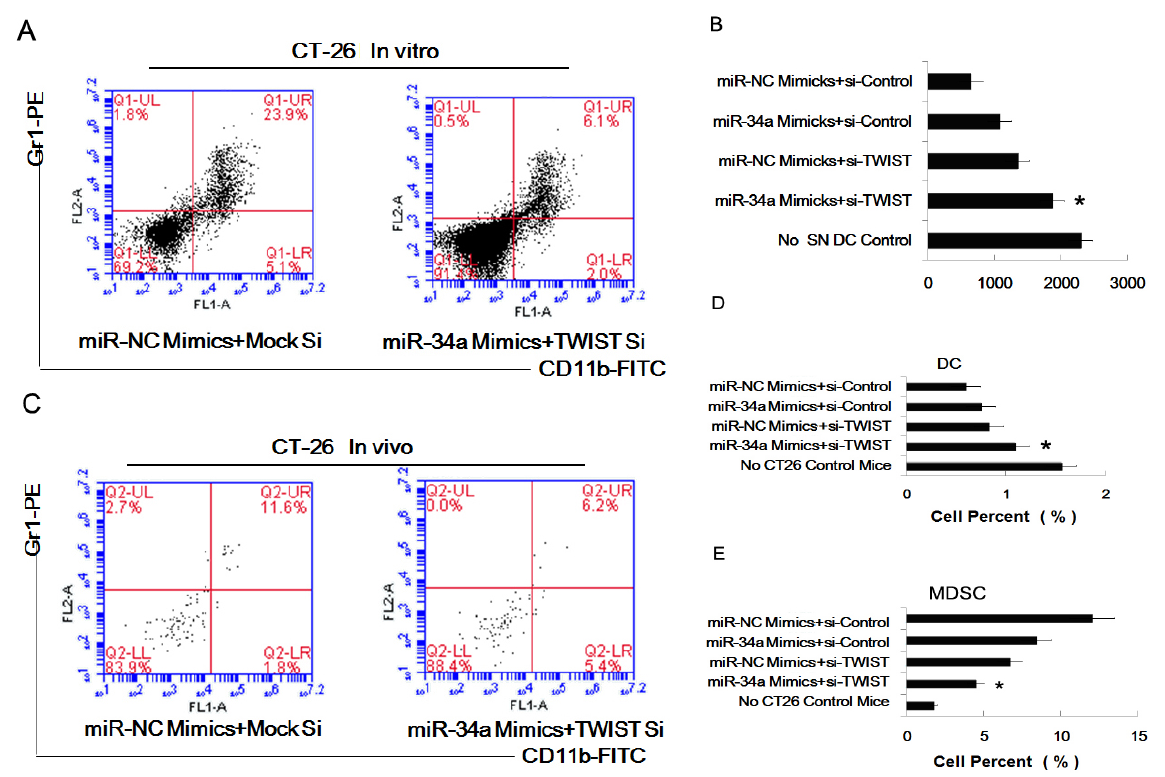
Figure 5. The combined effect of Twist and miR-34a in inducing MDSC. miRNA-34a mimics and Twist siRNA were combined to pretreated tumor cells. The supernatants of pretreated cells were collected and co-cultured with myeloid precursor cells; or the combined treated tumor cells were inoculated s.c. into C57BL/6 mice for the construction of tumor bearing mice model. After co-culture, these cell were purified to assess the percent of MDSC and the capacity to stimulate the proliferation of T cells. ( A ) Percent of MDSC (G1 + CD11b + ) in the pretreated cells population was assayed by FACS; ( B ) CD4 + T cells from DO11.10 OVA323–339-specific (TCR-transgenic × C57BL/6) F1 hybrid mice were co-cultured with four different pretreated myeloid precursor cells, 5 days later, the total number of viable CD4 + T cells (CD4 + 7AAD − ) cells in each well was measured by flow cytometry. Results are the mean ± SD of three independent analyses. * p < 0.05 SN, supernatants; ( C ) The spleens of tumor bearing mice were isolated for assaying the percent of MDSC (Gr1 + CD11b + ); ( D ) The percent of MDSC (Gr1 + CD11b + ) in spleens of tumor bearing mice were assayed by FACS. There are four different pretreatment combinations. Results are the mean ± SD of three independent analyses. * p < 0.05; ( E ) The percent of DC (CD11c + ) in spleens of tumor bearing mice was assayed by FACS. Results are the mean ± SD of three independent analyses. * p <